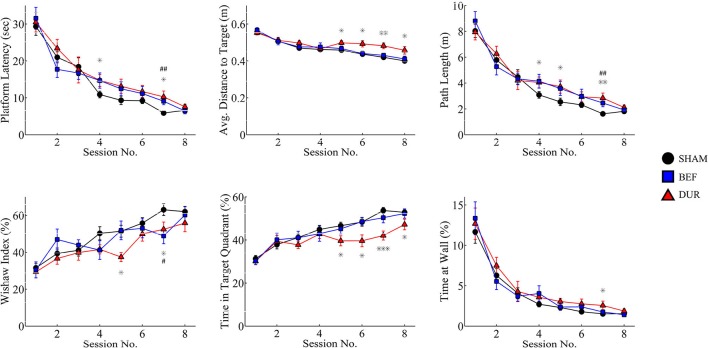
Acquisition data is shown for both stimulated and sham-stimulated rats. Statistical significance is shown for differences between groups for a given session; *p < 0.05; **p < 0.01; ***p < 0.001 when comparing DUR vs. SHAM rats, #p < 0.05; ##p < 0.01; ###p < 0.001 when comparing BEF vs. SHAM rats. Performance deficits are observed mainly in the rats receiving stimulation during the task (DUR), including an increased average distance to target and a reduced time spent in the target quadrant, compared to SHAM controls. This highlights a transient effect of DBS on task performance that is less pronounced in the BEF stimulation group.